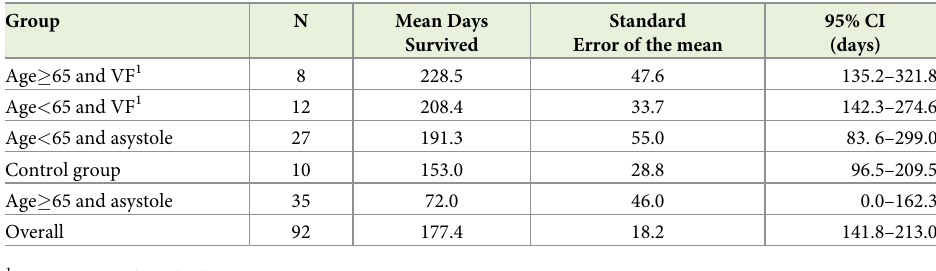
Table 4. 1-year mortality subgroup analysis (arranged by survival